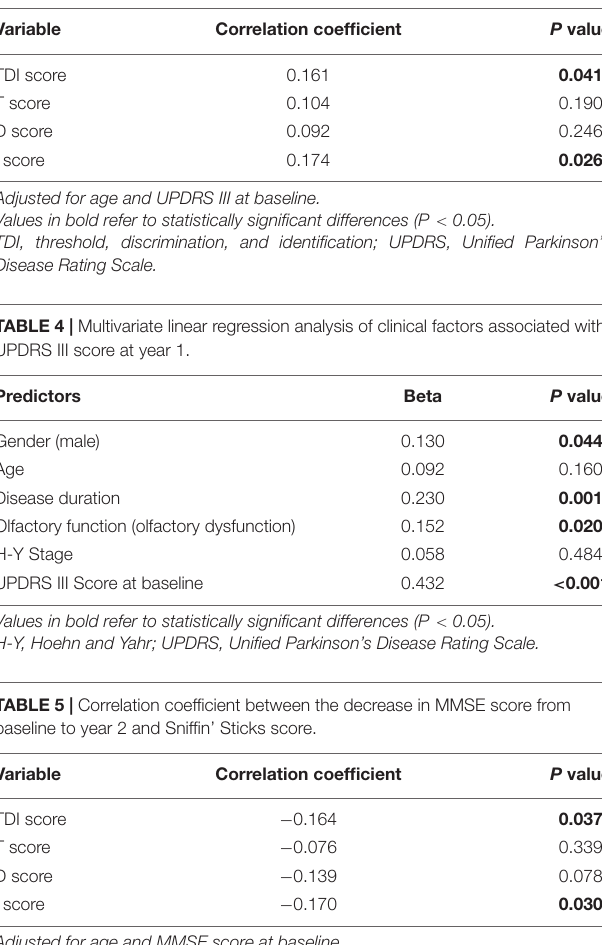
TABLE 3 | Correlation coefficient between the improvement in UPDRS III score from baseline to year 1 and Sniffin’ Sticks score.